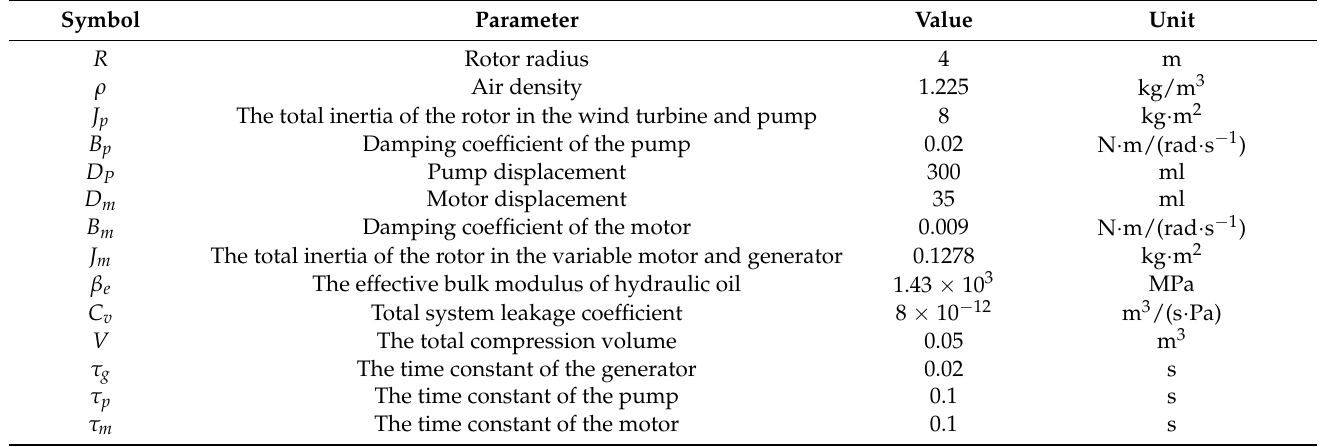
Table 1. Main parameters of the hydraulic wind